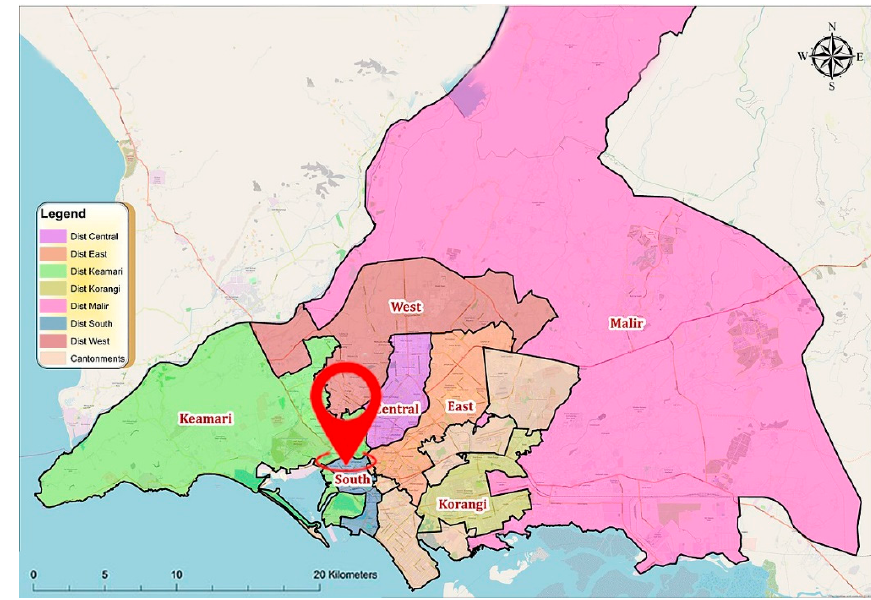
Figure 1. Karachi map with its districts and research area.